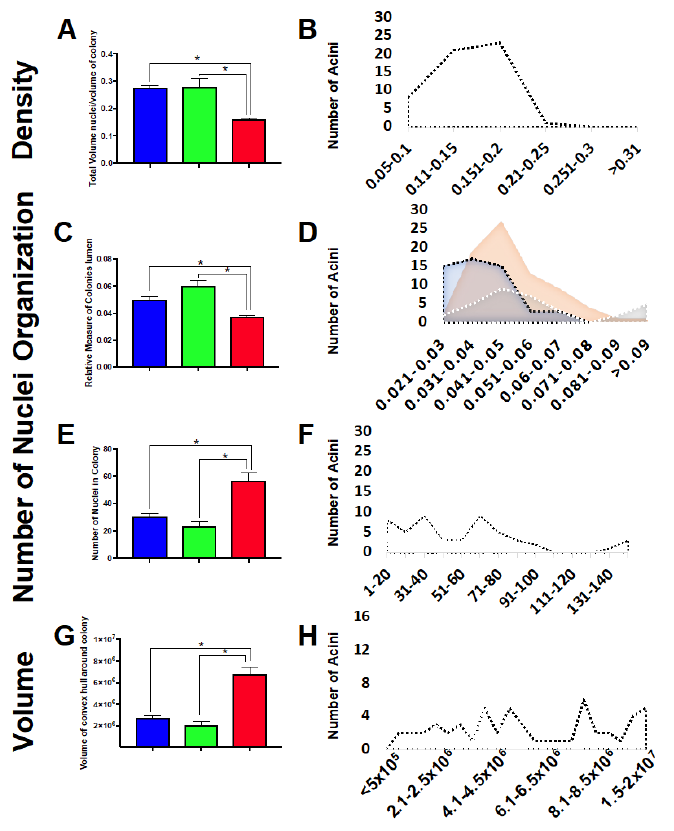
Figure 7. Three-dimensional acini growth changes quantified for control and simulated microgravity treated cell populations. Average values with standard error shown for each characteristic and group in ( A , C , E , G ). Values for each were binned to reveal in some cases sub-populations exhibiting varying degrees of each characteristic in ( B , D , F , H ), blue = control population, green = adherent population and red = non - adherent population of cells, (* p < 1 × 10 −5 ).